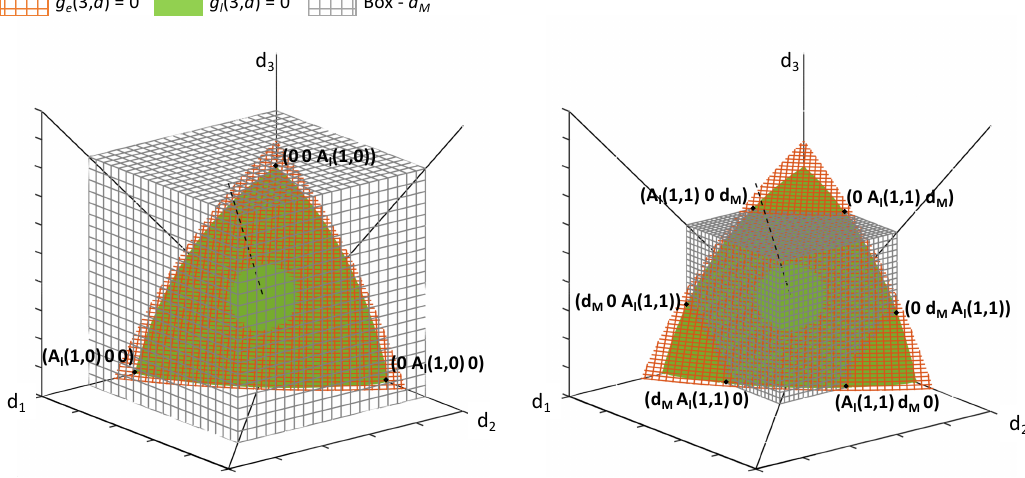
Figure 3. Qualitative example for n = 3 to illustrate the optima of Table 8. Behavior of the optimal solution for a tumor with ρ < ρ l in the absence of a prevalent constraint and for two d M values: ( Left ) d M > A l ( 1,0 ) ; and ( Right ) A l ( 2,0 ) < d M < A l ( 1,0 )